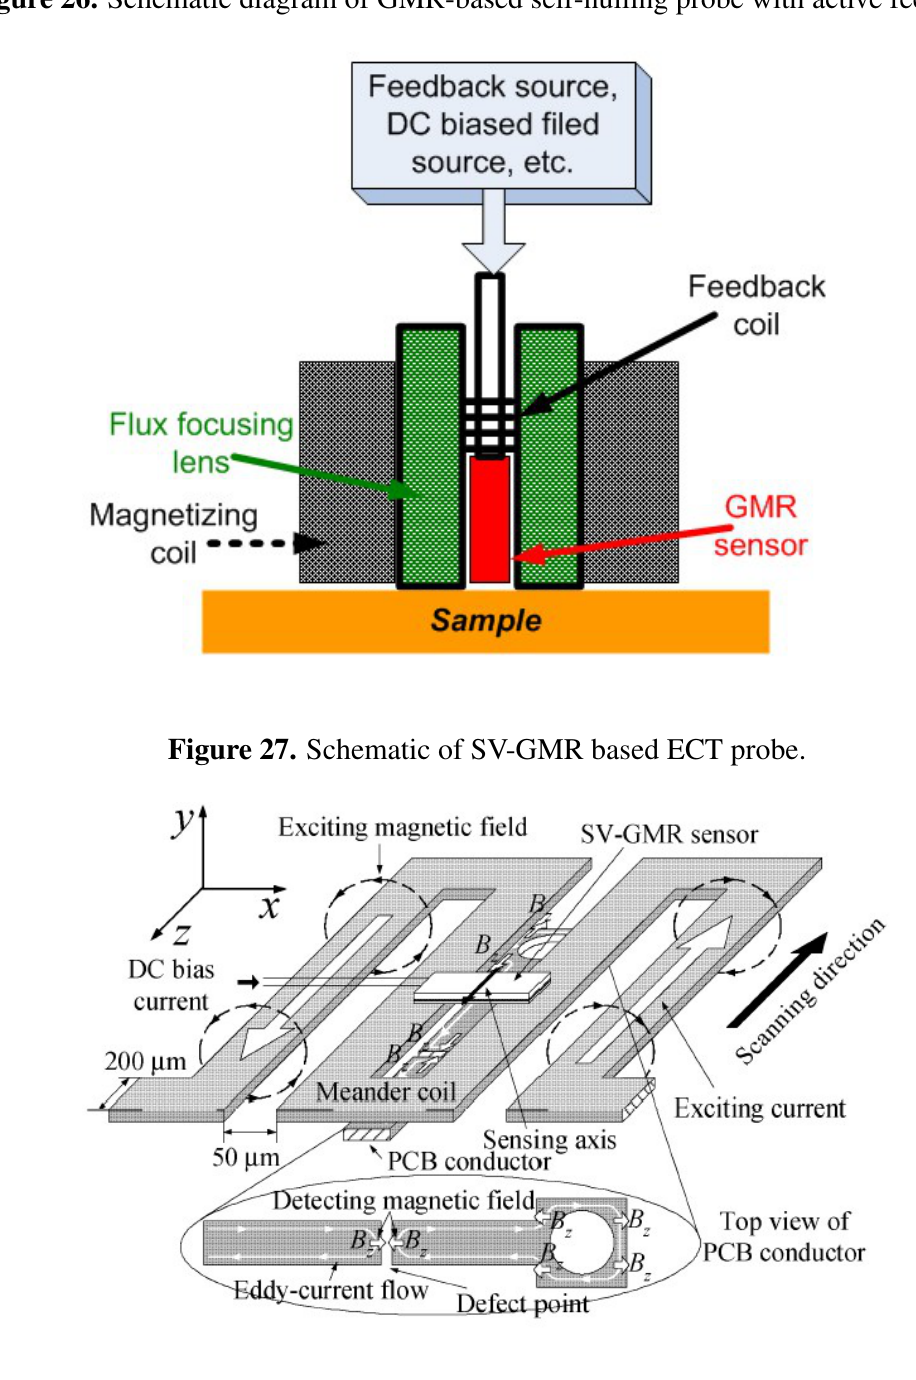
Figure 26. Schematic diagram of GMR-based self-nulling probe with active feedback.